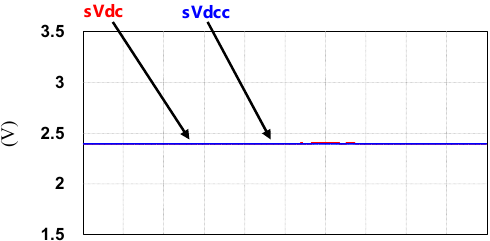
Figure 16. Shunt APF DC link voltage command and feedback signals (t 0 –t 2 ).